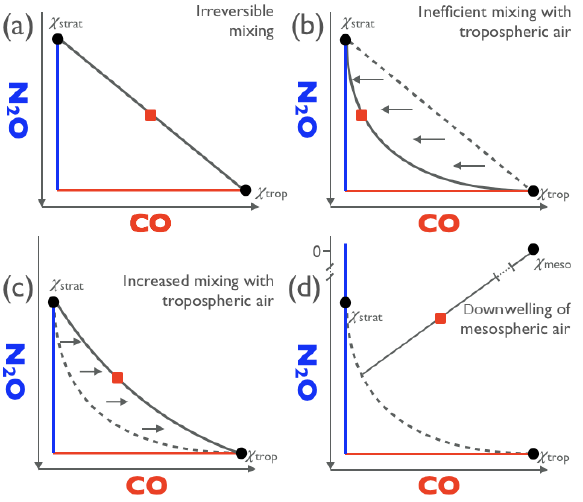
Figure 6. Sketch of tracer–tracer correlations with different life- times. Note that the N 2 O axis is reversed. Panel (a) shows the L- shaped structure with an air parcel (red box) on a straight mixing line for fast mixing timescales. The horizontal red line represents the tropospheric N 2 O background, the blue vertical line the strato- spheric CO equilibrium. Panel (b) shows the resulting curve in case of inefficient mixing compared to the chemical lifetime. Panel (c) shows the change in curvature depending on the strength of mixing and panel (d) shows the influence of the mesosphere on the correla- tion.